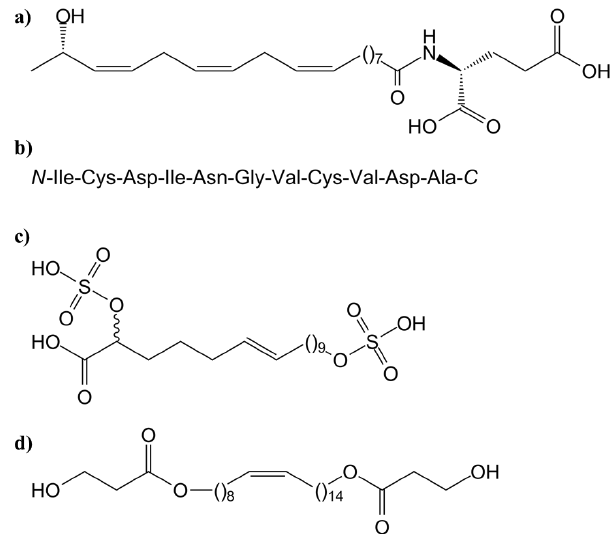
Figure 2. Structures of oral insect secretions. ( a ) Volicitin, N -(17-hydroxylinolenoyl)- L -Gln; ( b ) Inceptin, proteolytic peptides of the chloroplastic ATP synthase γ -subunit; ( c ) Caeliferin A16:1, ( E ) - 2,16 disulfooxy-6-hexadecenoic acid; and ( d ) Bruchin c, ( Z )-9-tetracosene-1,24-diol